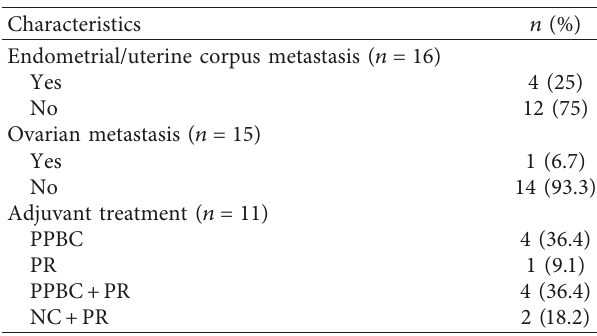
Table 1: Patients’ clinical characteristics ( n